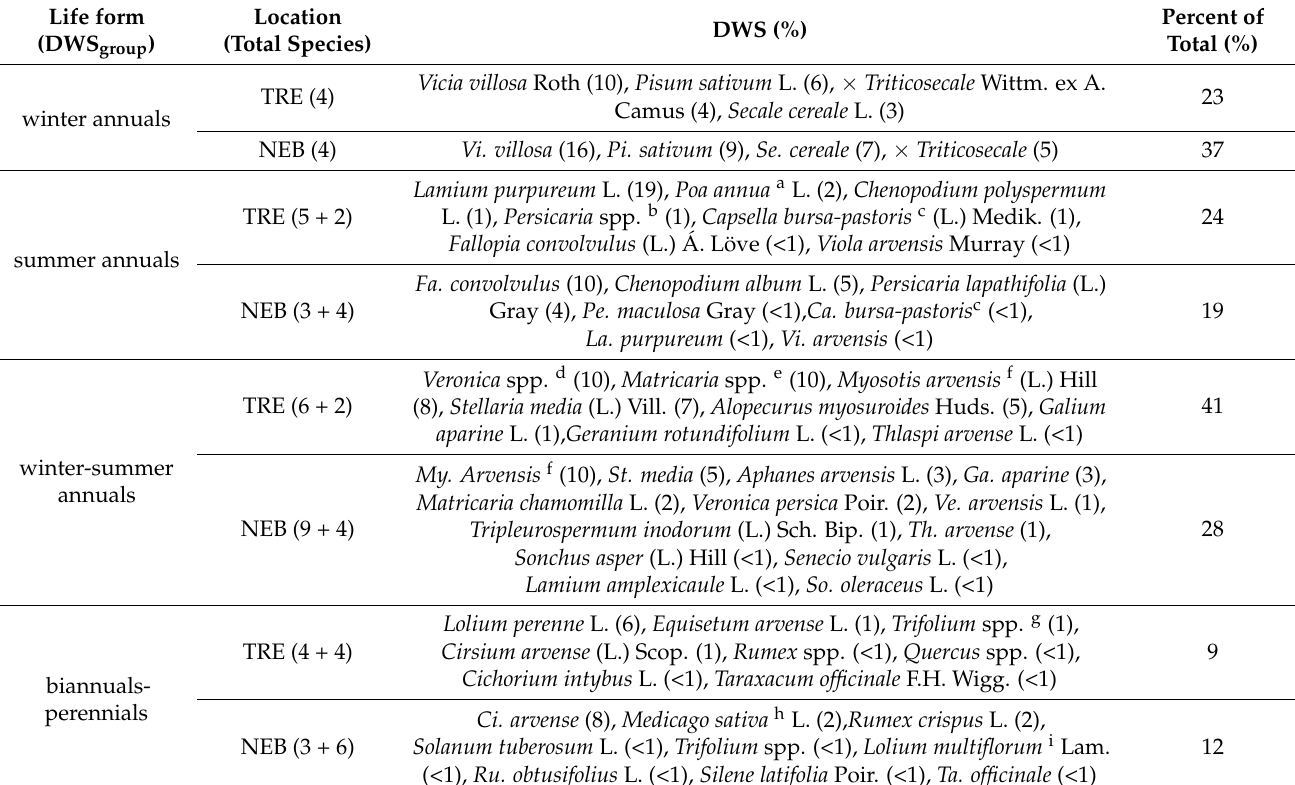
Table A3. Average representation of the species (%) on the field averaged over year in each DWS group at the locations. Sum of total species is put into parentheses and differentiated between more common and seldom (below 1% representation on the field) species. TRE = Trenthorst, NEB =